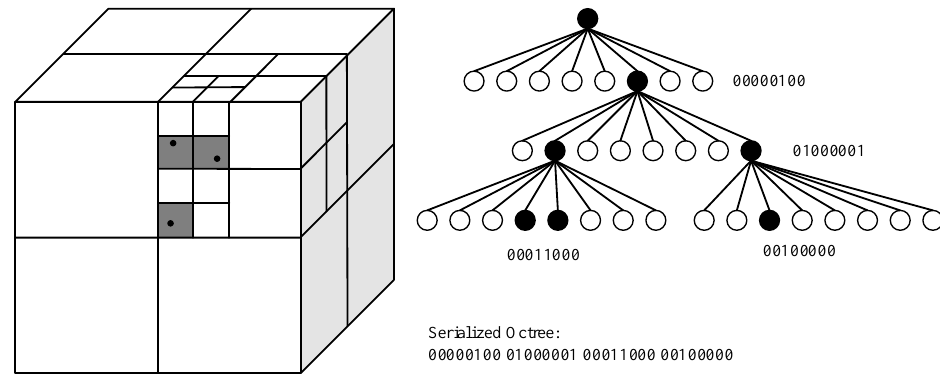
Figure 2. Schematic overview of the octree data structure and its serialization. Nodes in the tree that encapsulate points are marked as occupied (binary 1). These are the only nodes that have children. On the finest level, the division process is stopped, and the nodes that encapsulate points are marked as occupied. Figure c (cid:13) 2012 IEEE. Reprinted, with permission, from